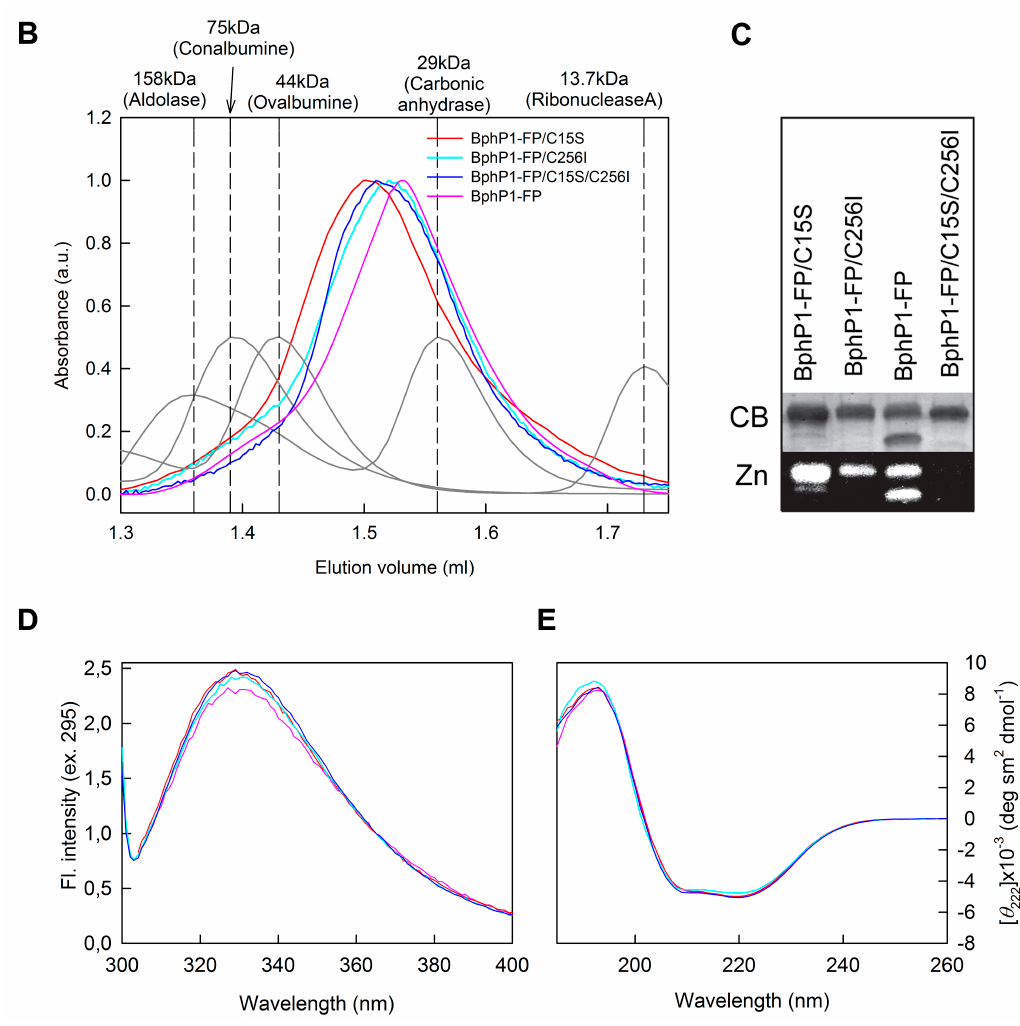
Figure 2. Characterization of BphPl-FP and its variants with different location of Cys residues. ( A ) Dimeric structure of RpBphP1-N70 without C-terminal HOS domain (PDB [31] ID: 4GW9 [30]). The graphic software VMD [32] and Raster3D [33] was used for drawing. Separate domains of RpBphP1-N70 monomer are differently colored; ( B ) Gel filtration of BphPl-FP, BphPl-FP/C15S, BphPl-FP/C256I and BphPl-FP/C15S/C256I proteins. The elution profiles of the proteins with known molecular mass used for the column calibration are shown in gray; ( C ) Covalent binding of biliverdin (BV) to proteins analyzed by sodium dodecyl sulfate polyacrylamide gel electrophoresis (SDS-PACE) followed by staining with Coomassie blue (CB) or by zinc-induced fluorescence of BV (Zn 2+ ); ( D ) Tertiary structure of proteins tested using Trp fluorescence; ( E ) Secondary structure of BphPl-FP variants tested using far circular dichroism (CD) spectra.